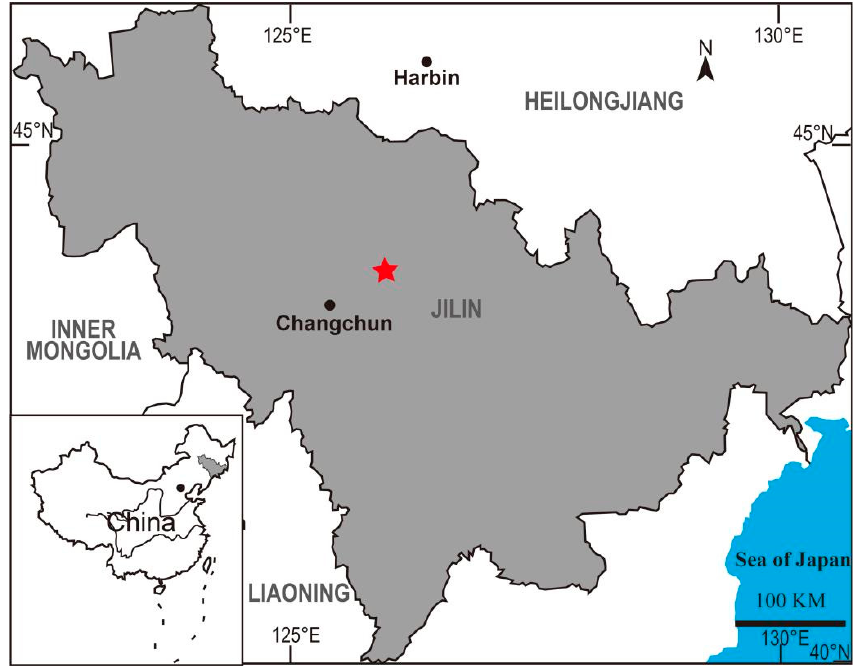
Figure 2. Location of Keteleerioxylon changchunense Shi, Sun, Meng et Yu sp. nov. in the Yingcheng Coal Mine (red star), Changchun City, Jilin Province, Northeast China.